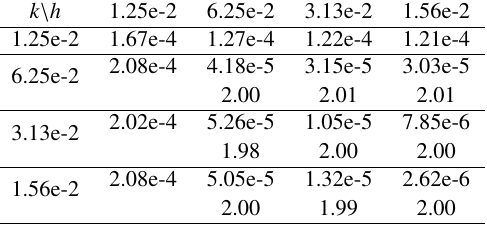
E rror and experimental order of convergence